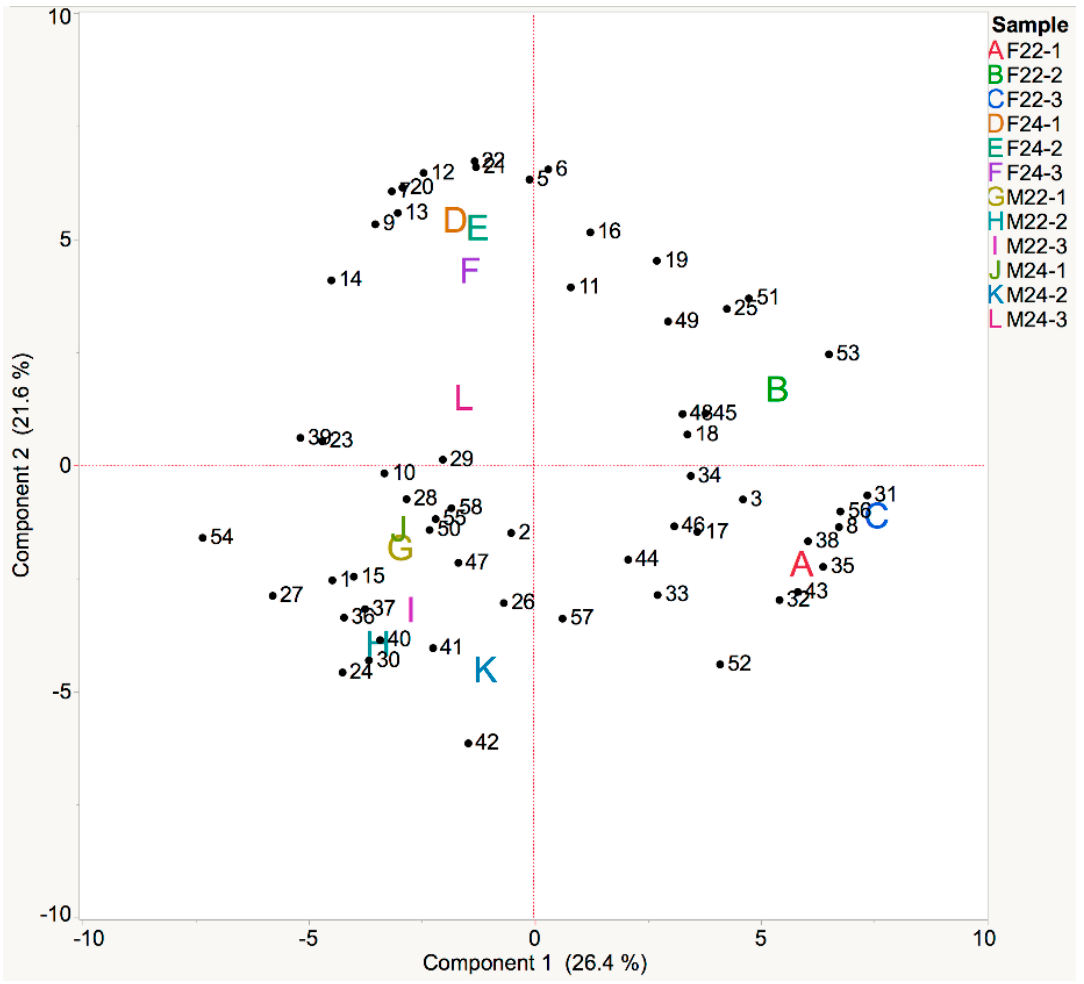
Figure 2. Results of a PCA on wines produced from Frontenac and Marquette berries harvested at 24 and 24° Brix. This biplot shows both the relationships of the wines to each other and the associations among the VOCs detected in the headspace. Vector arrows of the VOCs are not shown, but can be assumed to originate from the origin and ending at the numbered markers. The numbered markers indicate the compound identified, and are listed in Table 2. An example of sample naming convention is F22-1 used to represent wines produced from Frontenac berries, harvested at 22° Brix, analysis replicate 1.